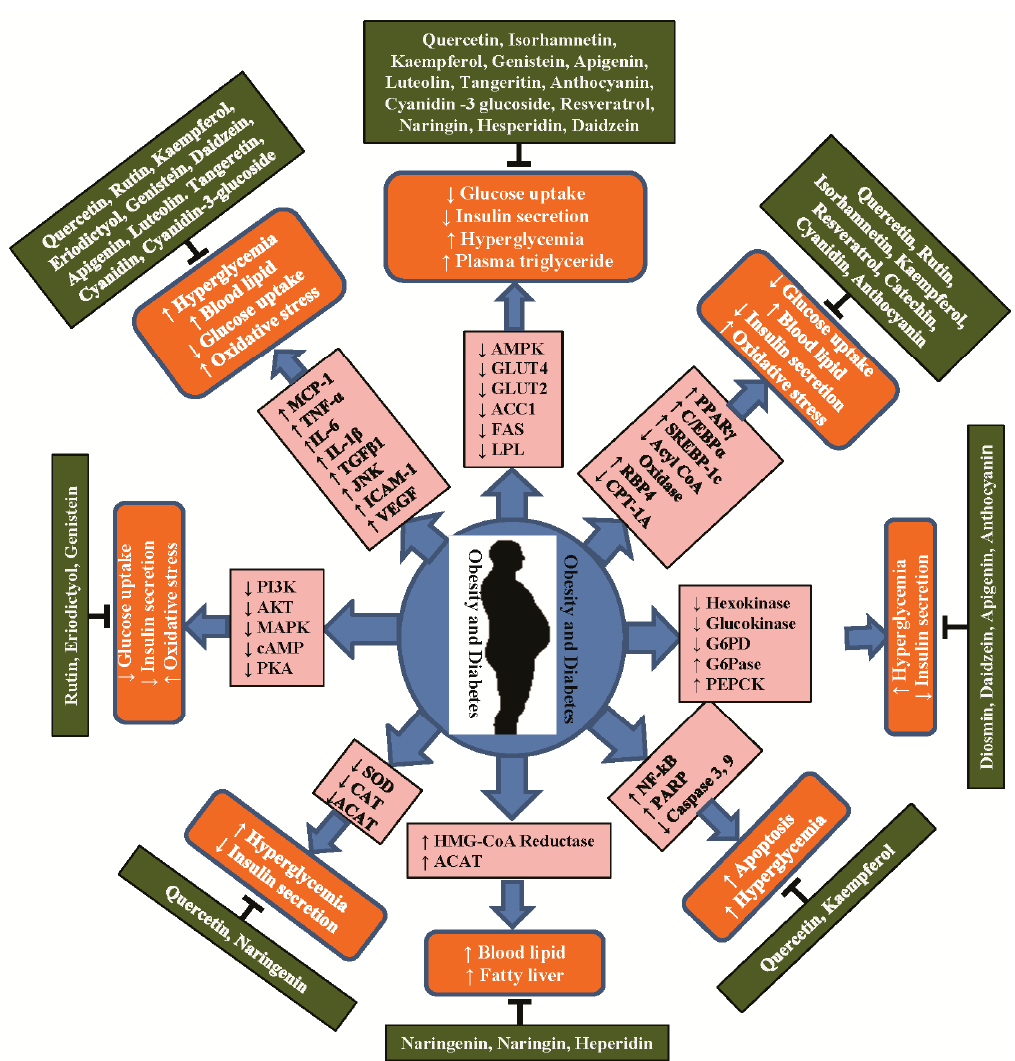
Figure 3. Schematic presentation of molecular functions of different flavonoids with anti-obesity and anti-diabetic effects. Obesity and diabetes stimulate increased or decreased production of inflammatory cytokines, expression of different metabolites, and intracellular cell signaling. Flavonoids showed anti-obesity and anti-diabetic effects by activating or inhibiting different cytokines, enzymes, and metabolites to prevent inflammation, oxidative stress, and metabolism to protect against obesity and diabetes. MCP-1: monocyte-chemo-attractant protein-1; TNF- α : tumor necrosis factor alpha; IL-6: interleukin-6; IL-1 β : interleukin 1 beta; FFA: free fatty acid, IRS1: insulin receptor substrate 1; PI3K: phosphatidylinositol 3-kinase; AKT: serine/threonine kinase; FA: fatty acid; IGT: impaired glucose tolerance; PARP: poly(ADP-ribose) polymerase; BCl-2: B-cell lymphoma 2; Bax: Bcl-2-associated X protein; Bak: Bcl-2 homologous antagonist/killer; Caspase 3: cysteine-dependent aspartate-directed proteases 3; PPAR γ : peroxisomal proliferator-activated receptor gamma; SREBP1c: sterol regulatory element binding protein-1c; LPL: lipo protein lipase; AMPK: 5 1 adenosine monophosphate-activated protein kinase; HOMA-IR: homeostatic model assessment for insulin resistance; HbA1c: hemoglobin A1c; GLUT4: glucose transporter 4; G6PDH: glucose-6-phosphate dehydrogenase; HMG-CoA: 3-hydroxy-3-methylglutaryl-coenzyme; ACAT: acyl CoA: cholesterol acyltransferase; G6pase: glucose-6-phosphatase; cAMP: cyclic adenosine monophosphate; PKA: protein kinase A. ( ↓ ) Decrease, ( ↑ ) Increase.